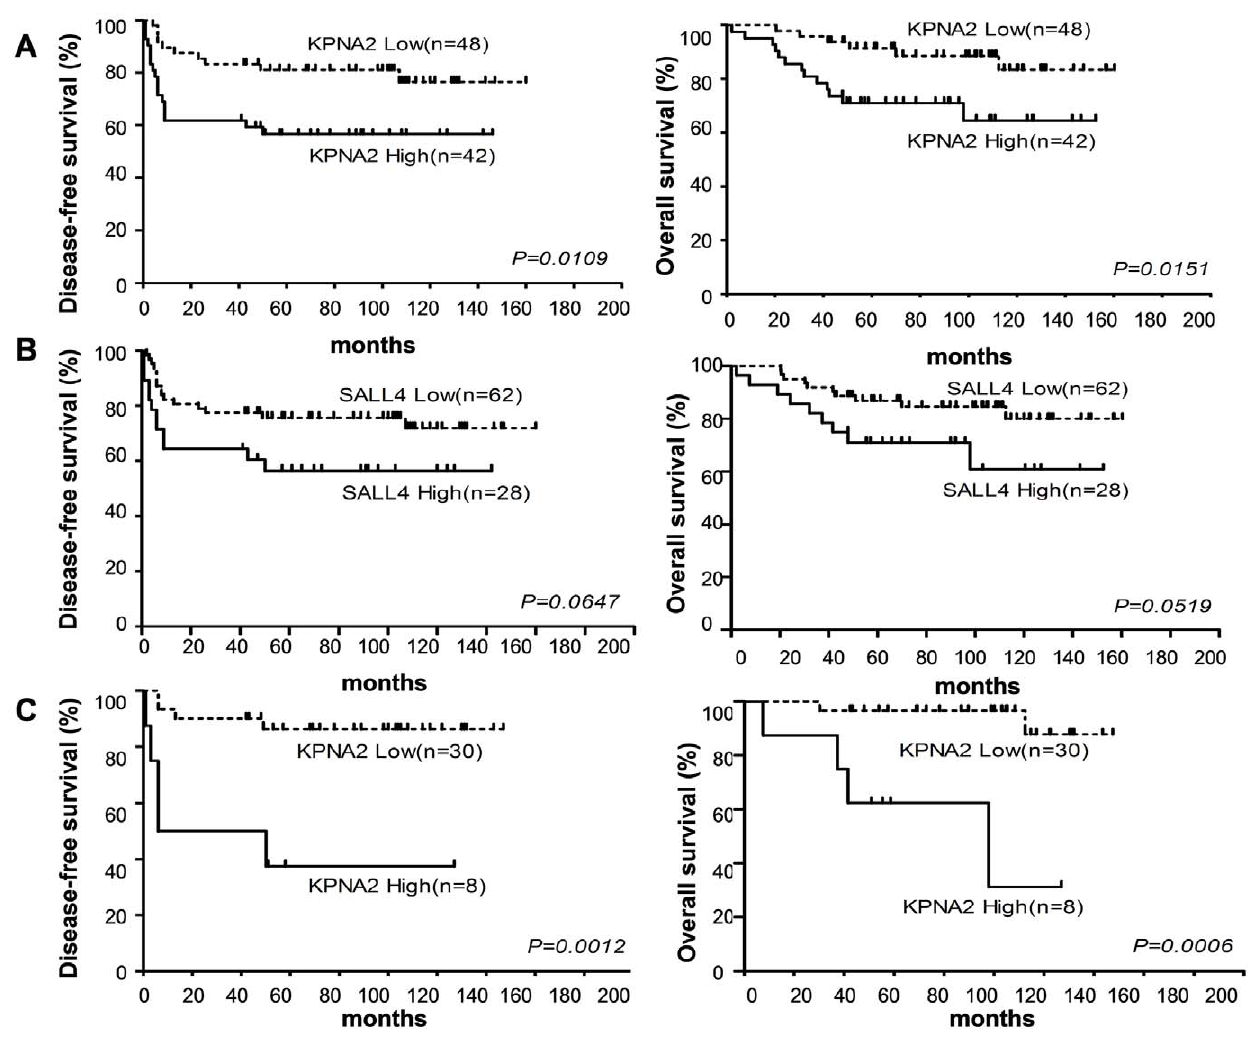
Figure 5. Prognostic assessment of positive KPNA2 and SALL4 expression in OMGCT and immature teratoma patients. A. There was statistically significant difference in both 5-year OS rate and DFS between KPNA2-low and KPNA2-high expression patients. B. There was marginally significant difference in both 5-year OS rate and DFS between SALL4-low and SALL4-high expression patients. C. There was significant difference in both 5-year OS rate and DFS between KPNA2-low and KPNA2-high expression immature teratoma patients. The graph plotted between estimated survival probabilities/estimated survival percentages (on Y axis) and time past after entry into the study (on X axis) consists of horizontal and vertical